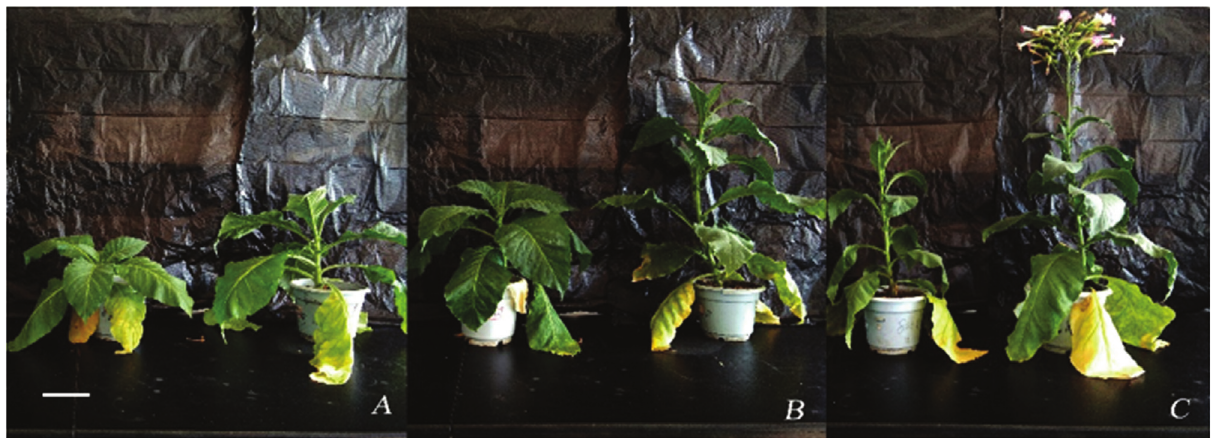
Figure 2 - Growth and development of tobacco in different periods. TT and WT grown for 90 (A), 120 (B), and 150 days (C). The left plant is WT, the right plant is TT. Bar size is 11.5